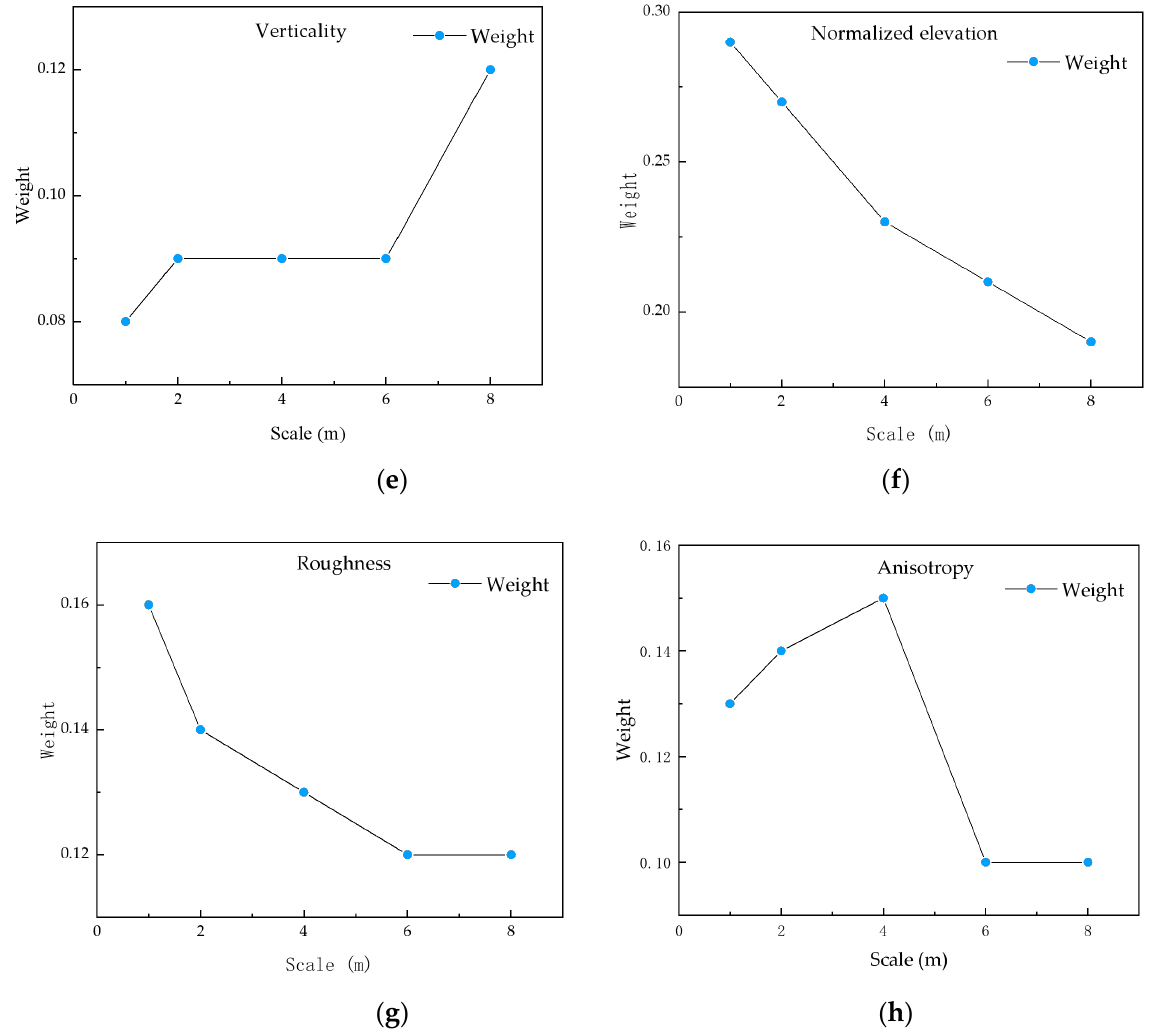
Figure 11. Multi-scale feature importance distribution.